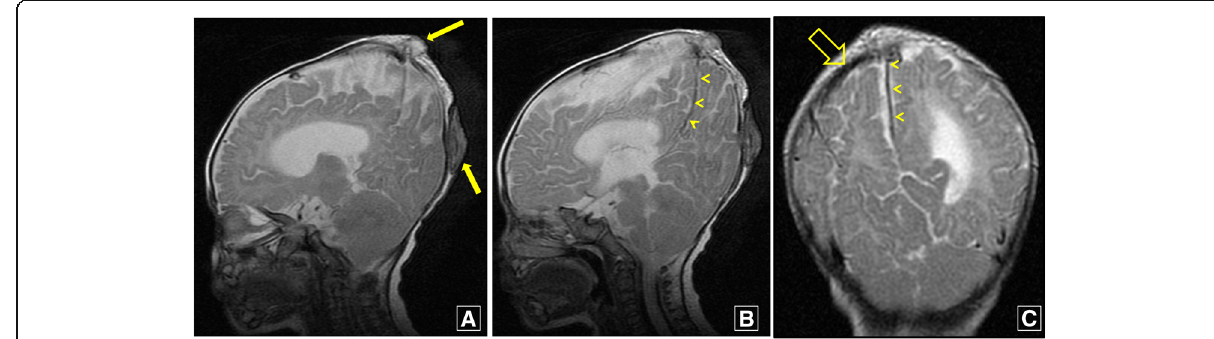
Fig. 9 Atretic encephalocele. ( a ) (T2-weighted sagittal image), ( b ) (T2-weighted sagittal image), and ( c ) (T2-weighted coronal image) show the presence of atretic encephalocele at the parietal and occipital locations (arrows). Note the vertical sigmoid sinus (persistent falcine sinus shown by arrowheads and vertical course of right transverse sinus shown by open arrow (not seen in its entire course on the single image). The left transverse sinus was hypoplastic